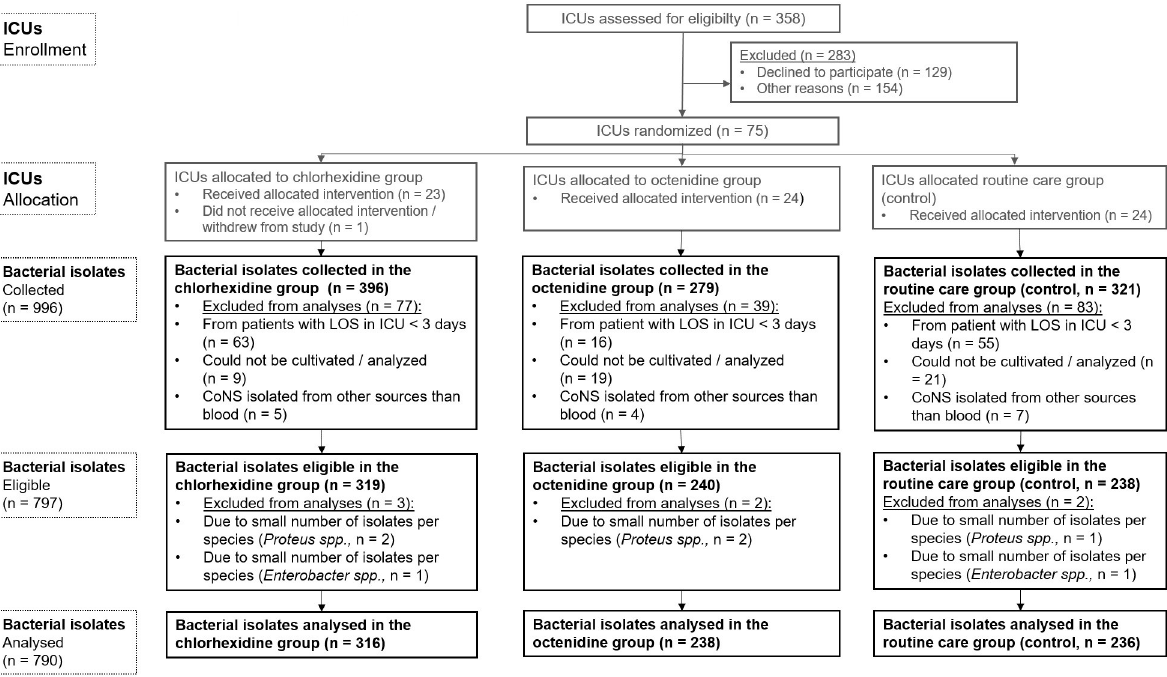
Fig 1. Flow chart of ICU-attributable bacterial isolates from clinical samples eligible for analyses of susceptibilities to chlorhexidine and octenidine and included to descriptive analyses. CoNS, coagulase-negative staphylococci, ICU, intensive care unit. spp., subspecies.